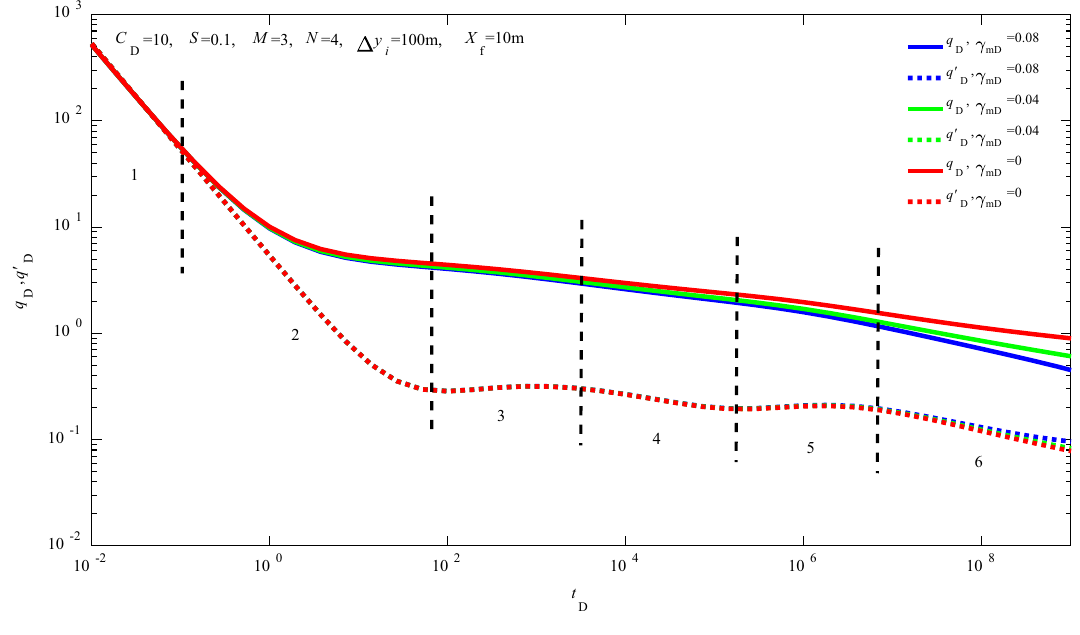
Fig. 8 Effect of permeability modulus on rate decline